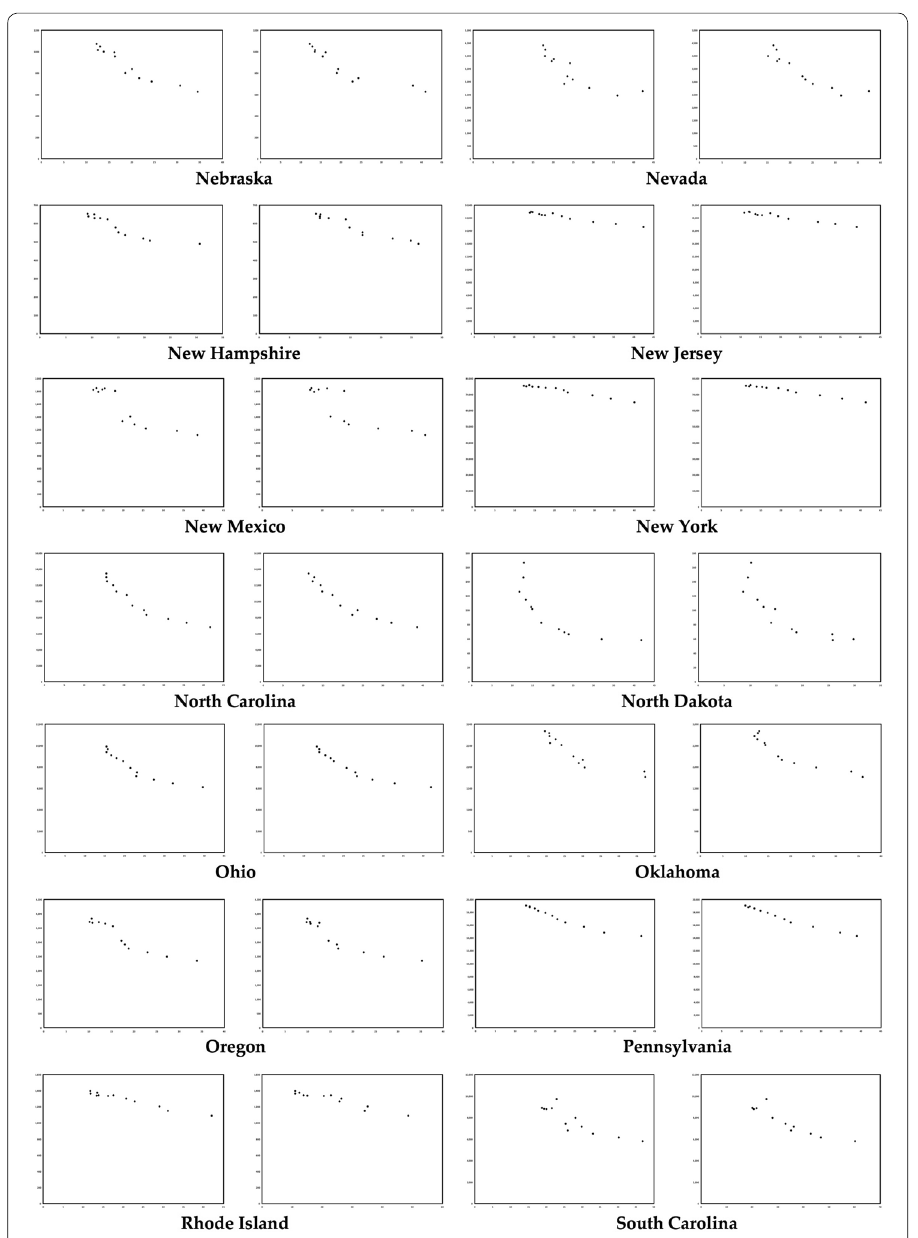
Fig. 6 ‘AIDS Prevalence’ vs. Google Trends ‘AIDS (Search Term)’ and ‘AIDS (Illness)’ from January 2004